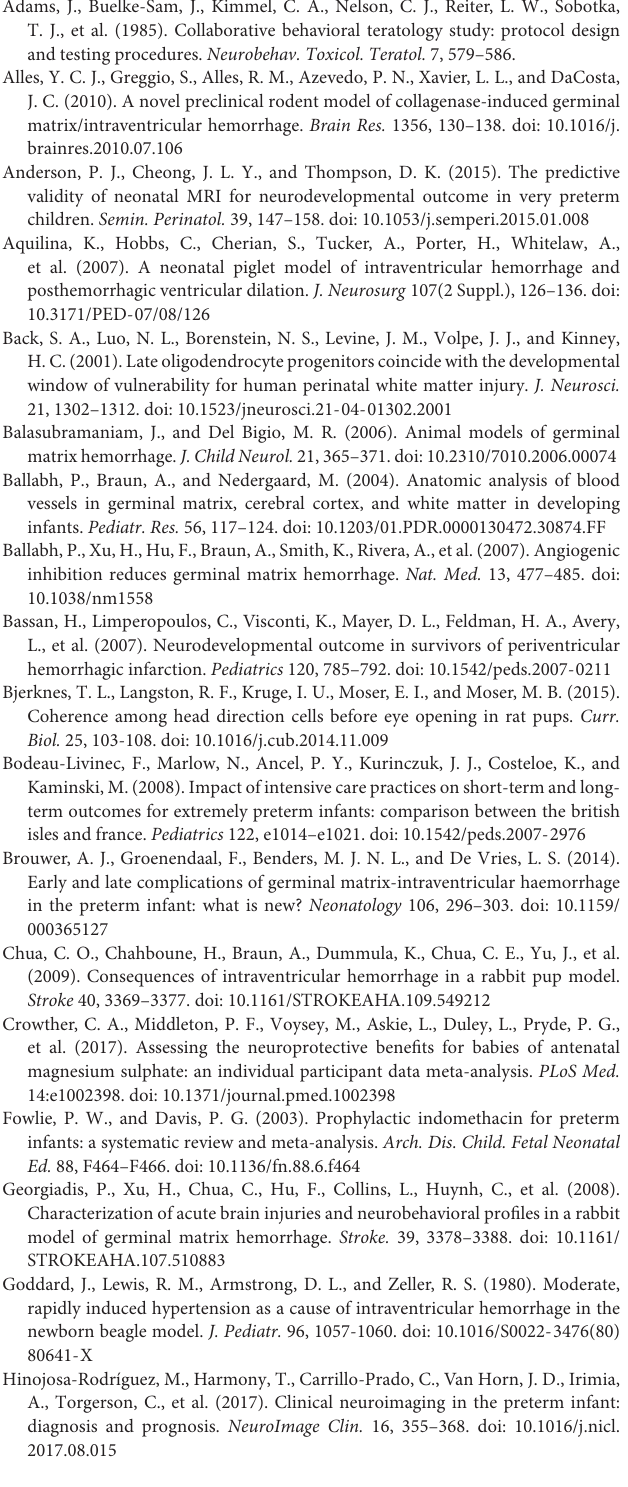
Supplementary Figure 4 | (A) Assessment of astrogliosis (GFAP) and (B) microglia activation (IBA-1) at P40 between naïve ( n = 5), saline ( n = 12), and